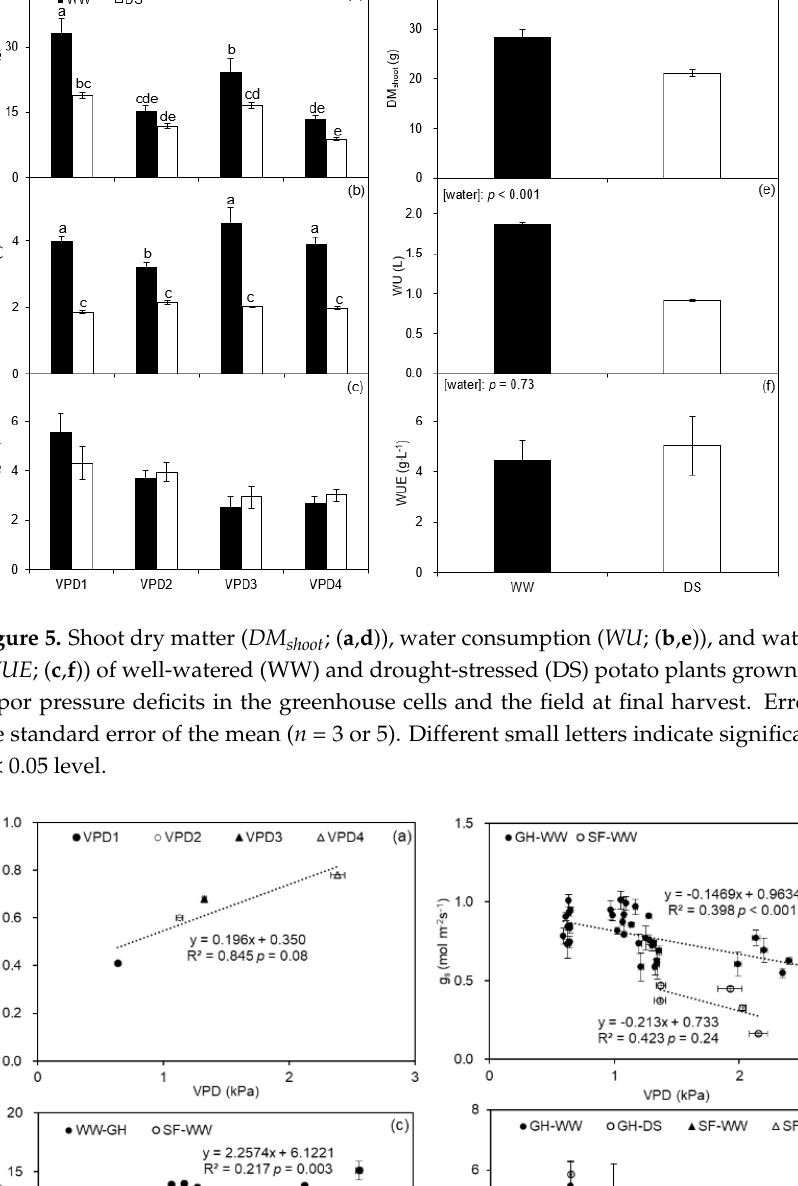
Figure 5. Shoot dry matter ( DM shoot ; ( a , d )), water consumption ( WU ; ( b , e )), and water use efficiency ( WUE ; ( c , f )) of well-watered (WW) and drought-stressed (DS) potato plants grown under different vapor pressure deficits in the greenhouse cells and the field at final harvest. Error bars indicate the standard error of the mean ( n = 3 or 5). Different small letters indicate significant difference at p < 0.05 level.